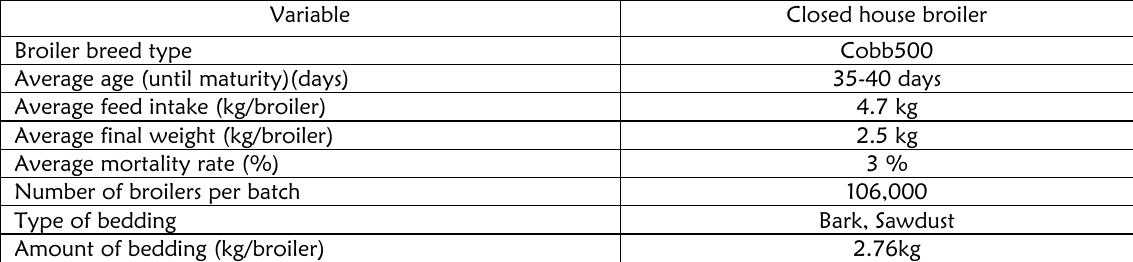
Table 2: Parameters used by the broiler